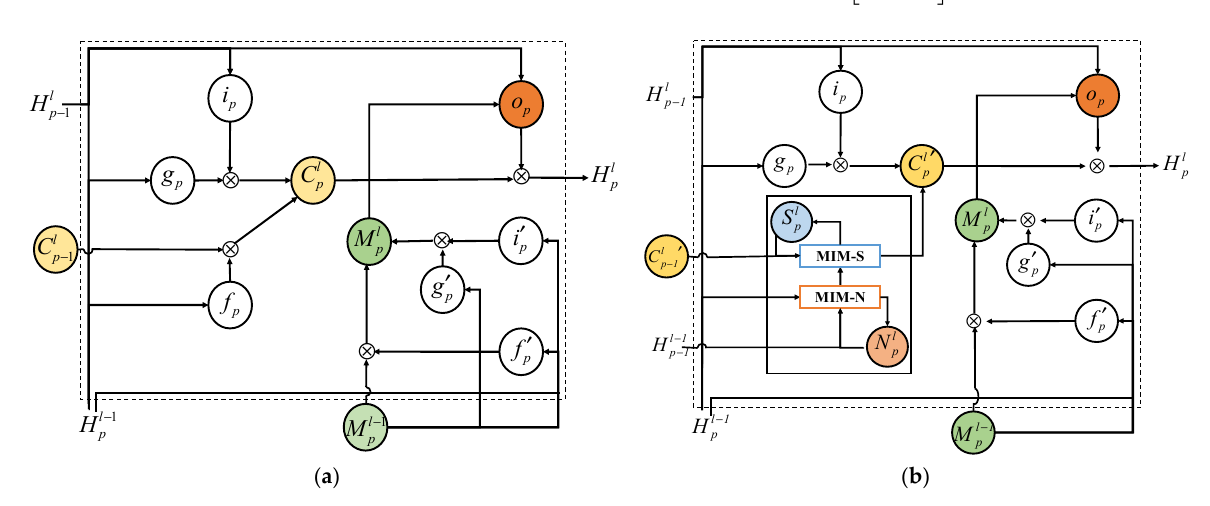
Figure 3. Structure diagram of ST-LSTM ( a ) and MIM ( b ) cell.